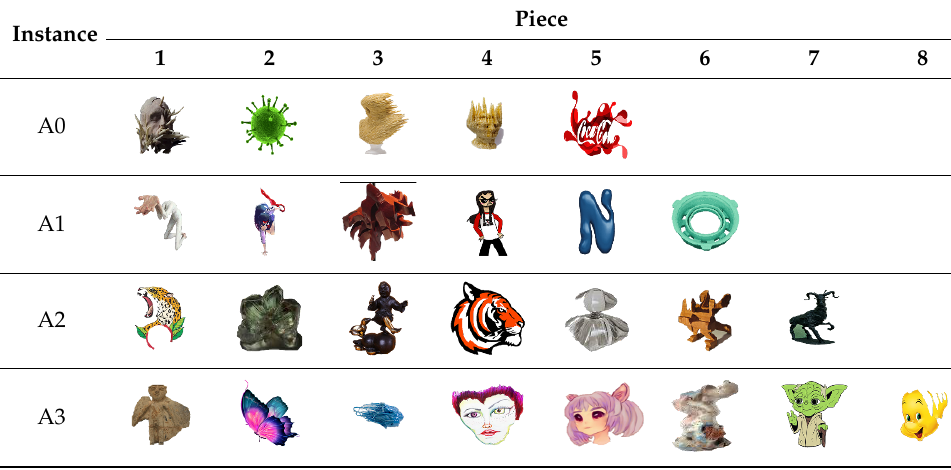
Table 9. Amorphous pieces used in each instance.